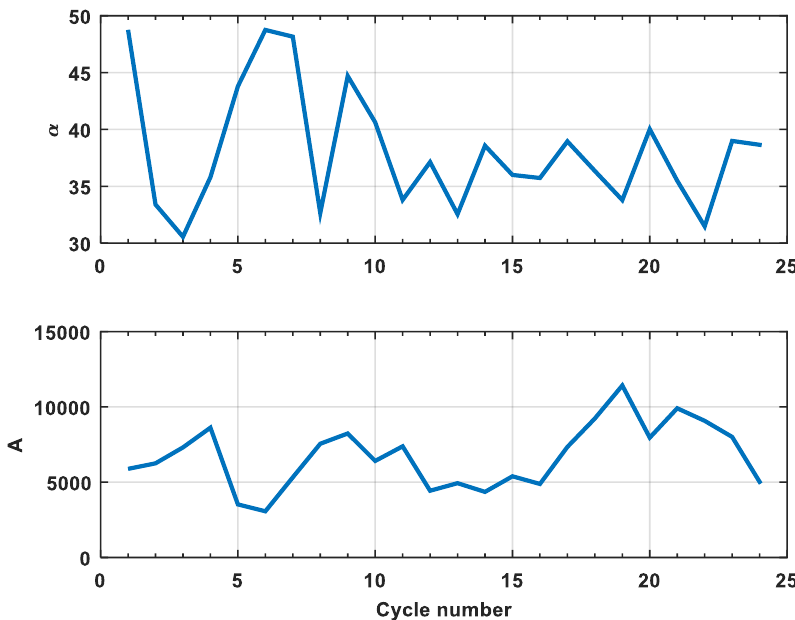
Figure-6. The parameters α and A for all the 24